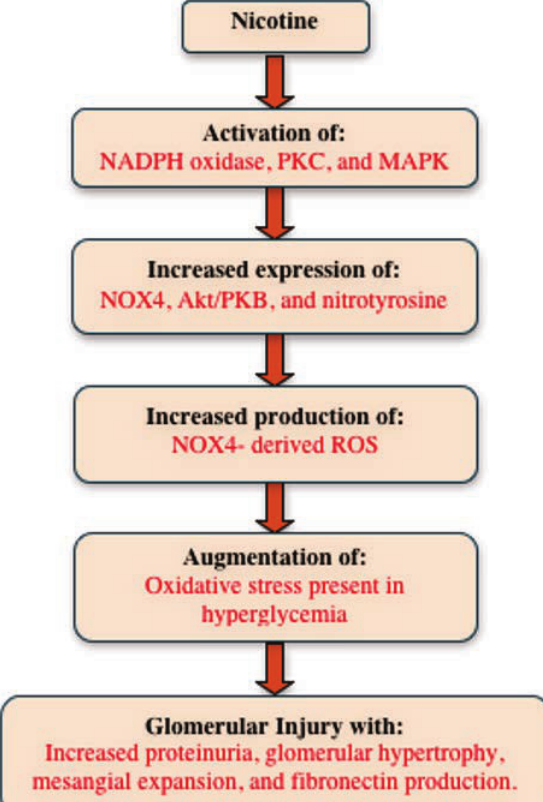
Figure 2. A simplified illustration of the mechanism by which smoking accelerates renal injury. Starting with nicotine dependent activation of NADPH oxidase, PKC, and MAPK, a cascade of pathophysiologic events is initiated ending by augmentation of oxidative stress already present in hyperglycemia with consequent glomerular injury and proteinuria